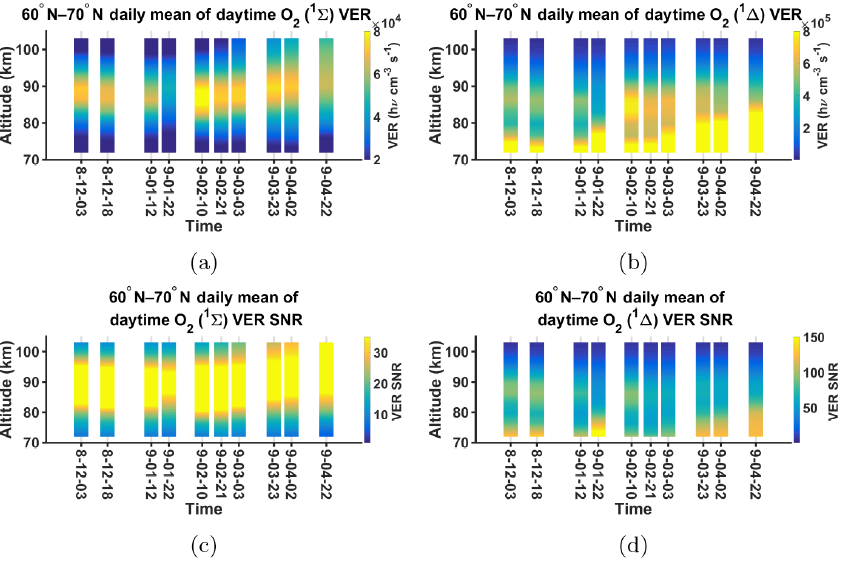
Figure 10. (a) Daily mean of the daytime O 2 ( 1 (cid:54)) VER from December 2008 to April 2009 averaged between 60 and 70 ◦ N latitude. (b) as (a) for the O 2 ( 1 (cid:49)) band. (c) Daily mean of the signal-to-noise ratios of the daytime O 2 ( 1 (cid:54)) VER from December 2008 to April 2009 averaged between 60 and 70 ◦ N latitude. (d) as (c) for O 2 ( 1 (cid:49)) VER signal-to-noise